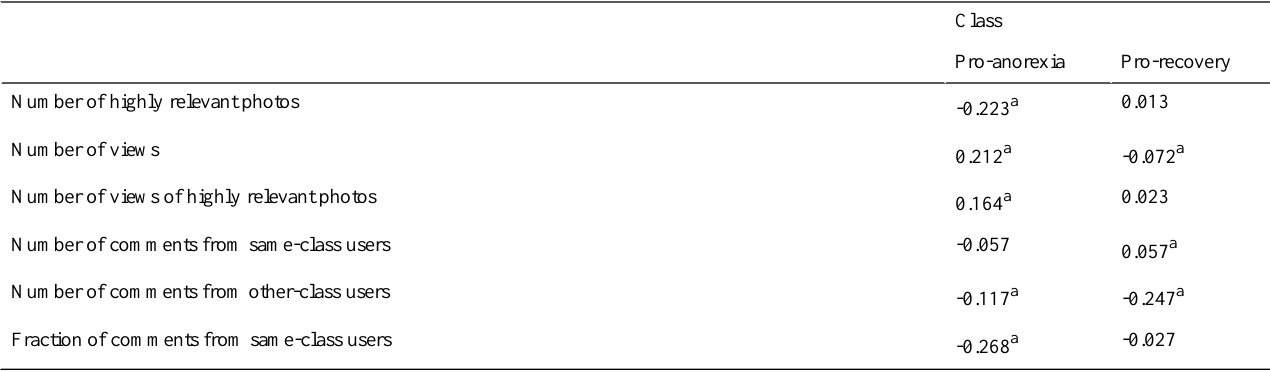
Table 2. Hazard model coefficients; all previous times.